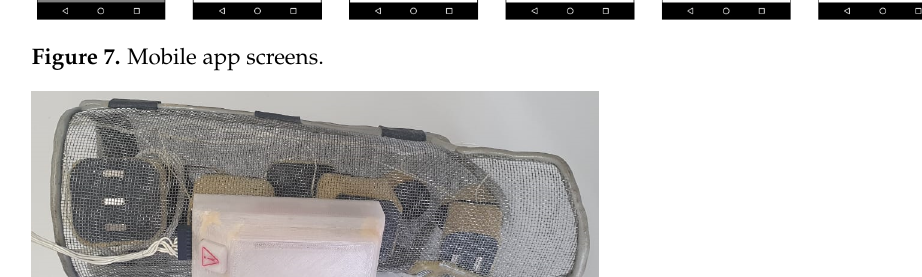
Figure 8. Orthosis with the electrodes and the STIMGRASP